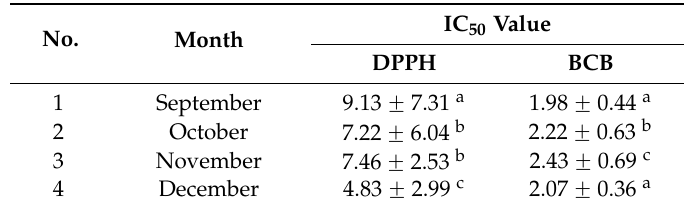
Table 4. IC 50 value for the DPPH radical-scavenging ability and β -carotene bleaching inhibition about the essential oils of B. balsamifera in different months.